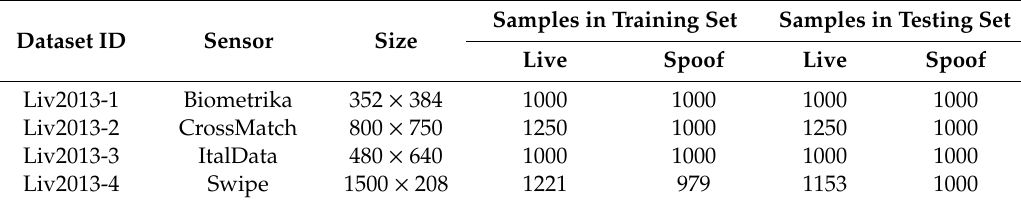
Table 3. The image distribution of the LivDet 2013 dataset.